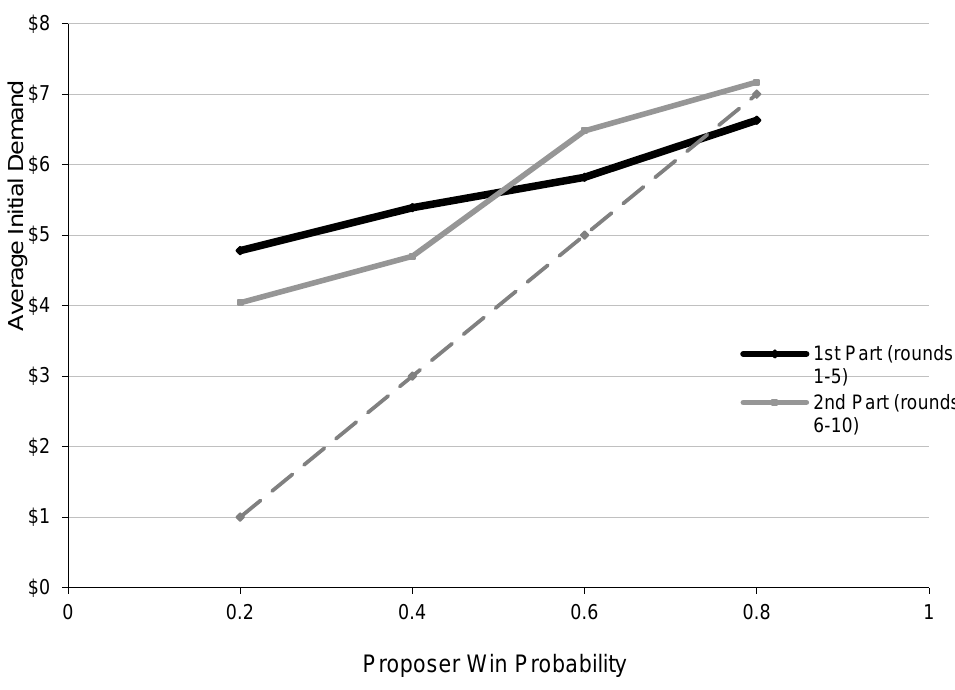
Figure 1. Average Proposer Demand by